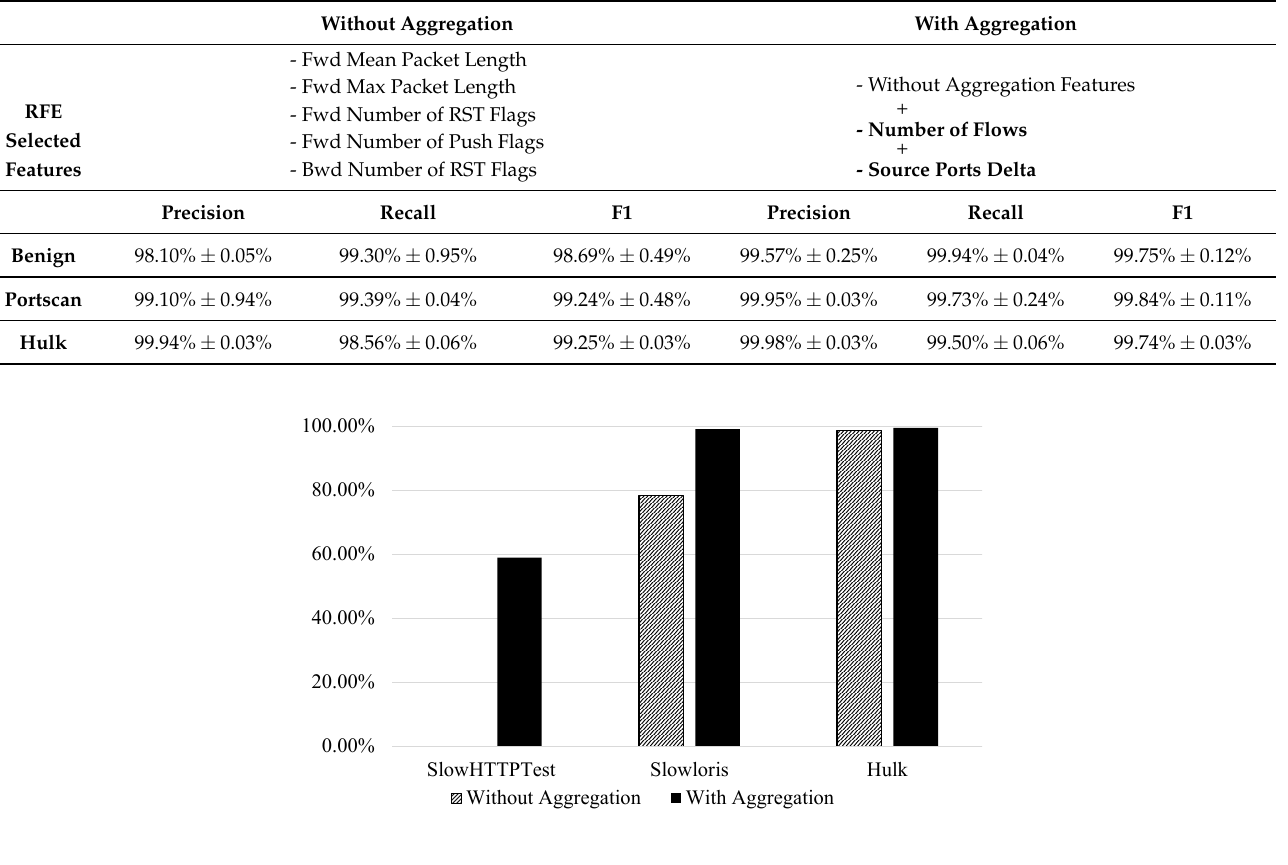
Figure 4. Multi-class classification|Impact of aggregation on the second attack class recall (benign vs. PortScan vs. attack